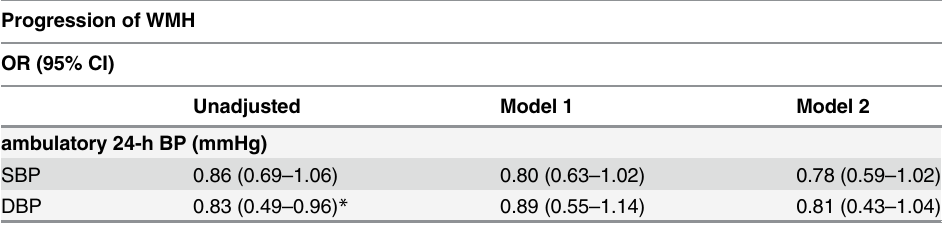
Table 4. Association between baseline ambulatory 24-hour blood pressure levels and progression of WMH by binary logistic regression analysis.